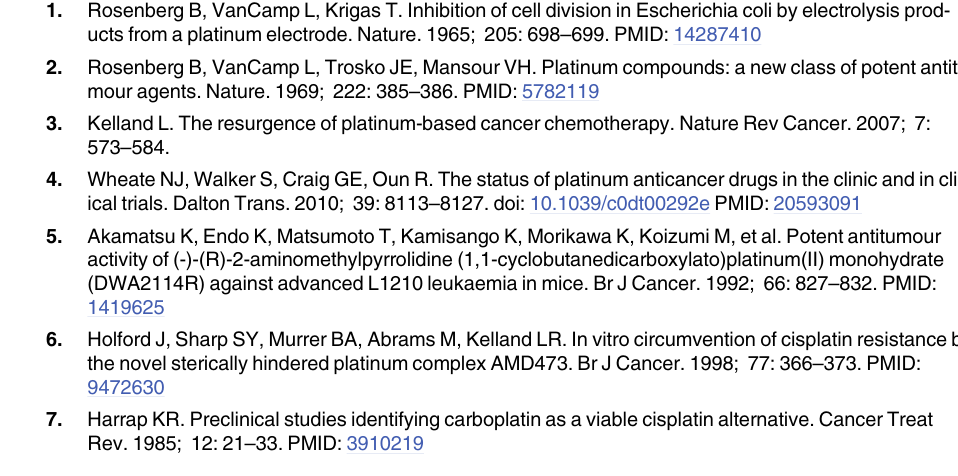
S1 Table. The 1 H, 13 C and 15 N NMR coordination shifts ( Δδ = δ 1 – 5. S2 Table. The results of the studies of the ability of the tested compounds to inhibit 20S proteasome activity assayed in purified proteasome obtained from A2780 cancer cell